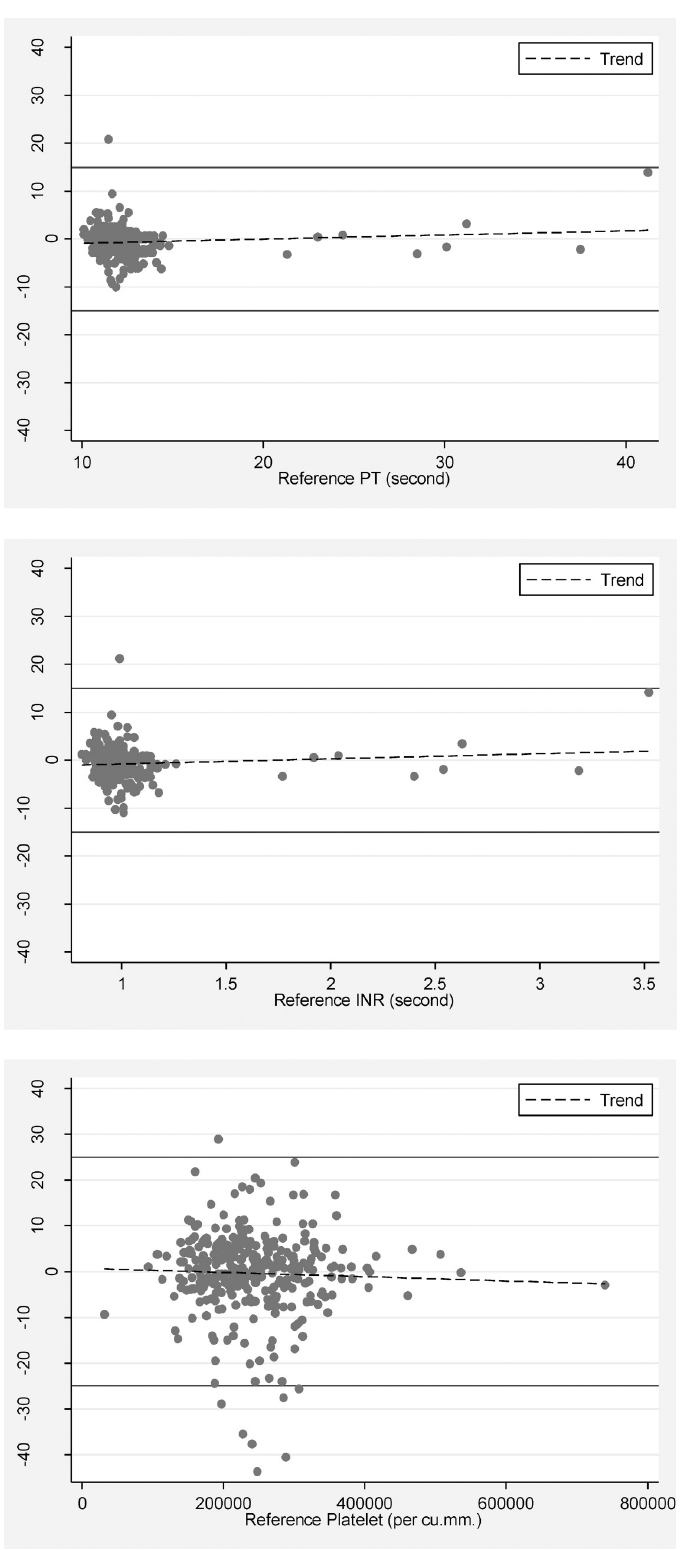
Fig 2. Modified Bland-Altman plots of prothrombin time (PT), international normalized ratio (INR), and platelet counts. https://doi.org/10.1371/journal.pone.0214874.g002 PLOS ONE | https://doi.org/10.1371/journal.pone.0214874 April 10,